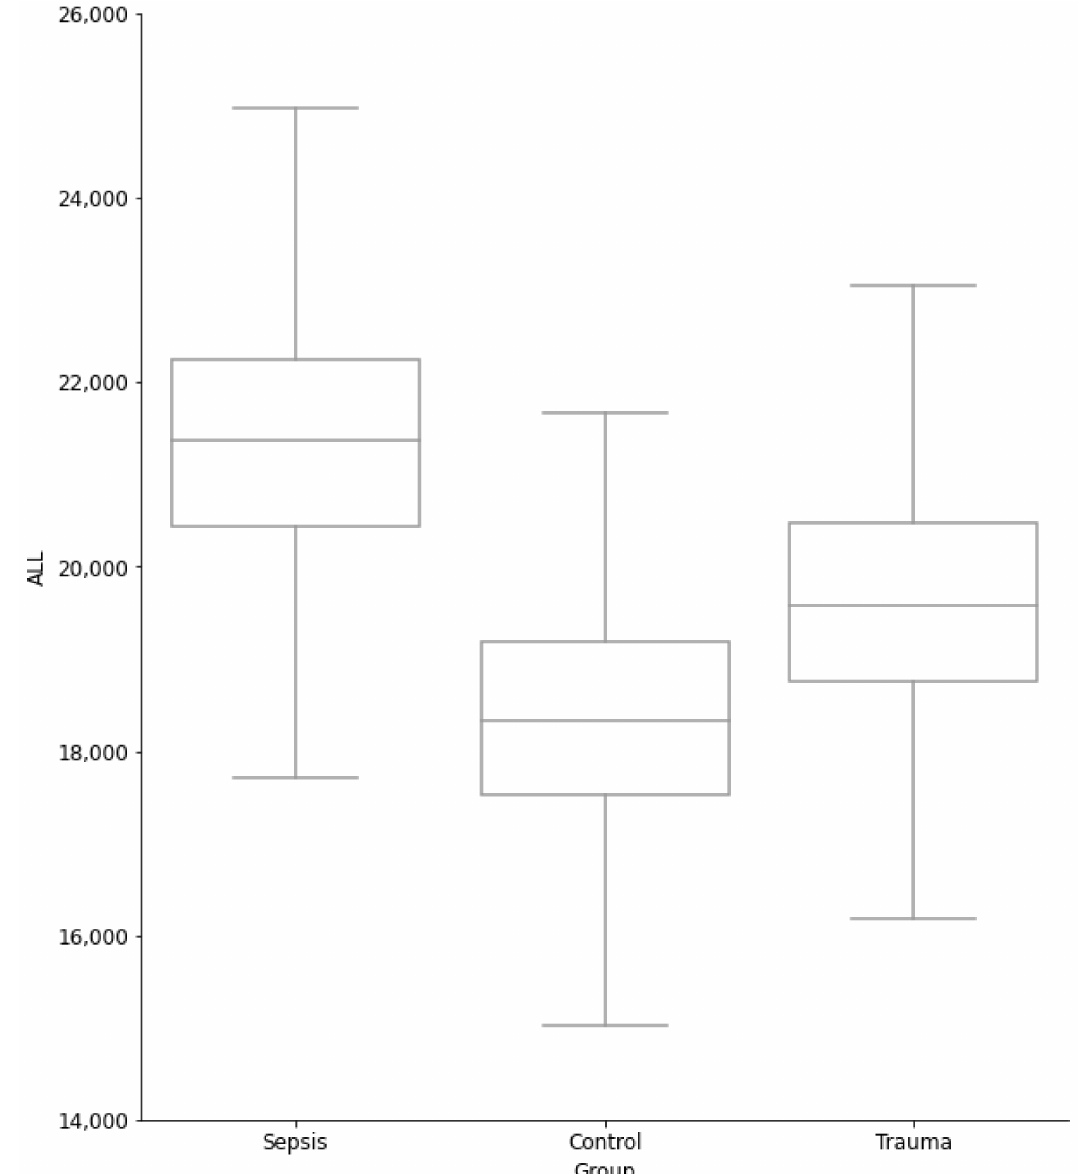
Figure 3. Boxplots for the three groups for the ALL measurement after combining all clusters that described a subpopulation of neutrophils. Sepsis patients had, on average, the largest neutrophils (as measured by ALL), followed by trauma patients. The controls had, on average, the smallest number of